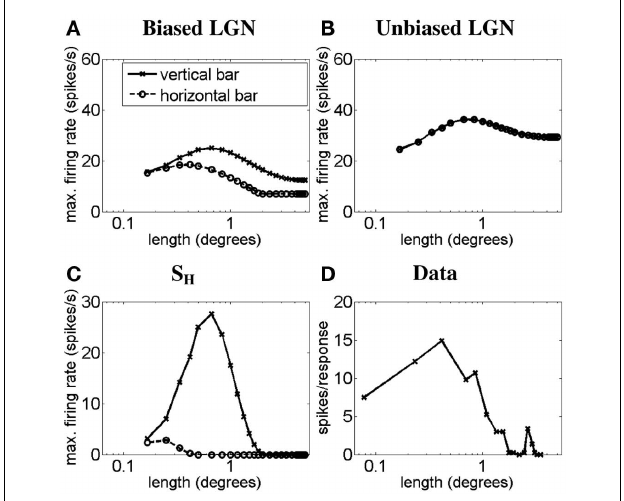
FIGURE 3 | Length–response function of the simple-like hypercomplex cell showing end-stopping. The plots show simulated length–response functions of (A) an ON LGN cell with a vertically biased center and a strong isotropic inhibitory surround, (B) an ON LGN cell with an isotropic center and a weak isotropic inhibitory surround, and (C) the corresponding vertically oriented simple-like hypercomplex cell with end-stopping in response to a vertical bar (solid lines) and a horizontal bar (dashed lines). (D) The length–response function of a real simple-like hypercomplex cell in response to a bar of the preferred orientation (Data adapted from Kato et al., 1978). Axes are the same as defined in Figure 2 .